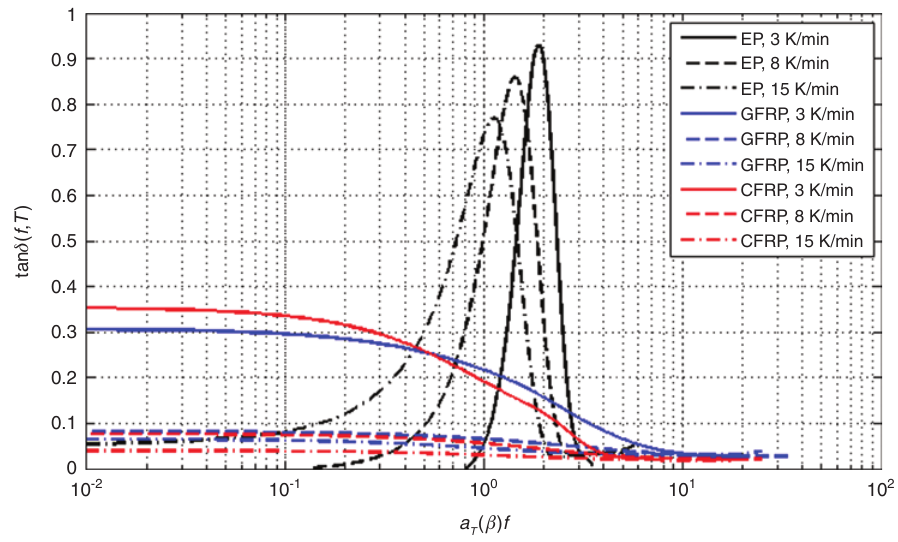
Figure 7: Master curves of the tangent loss factor for various materials and heating rates.